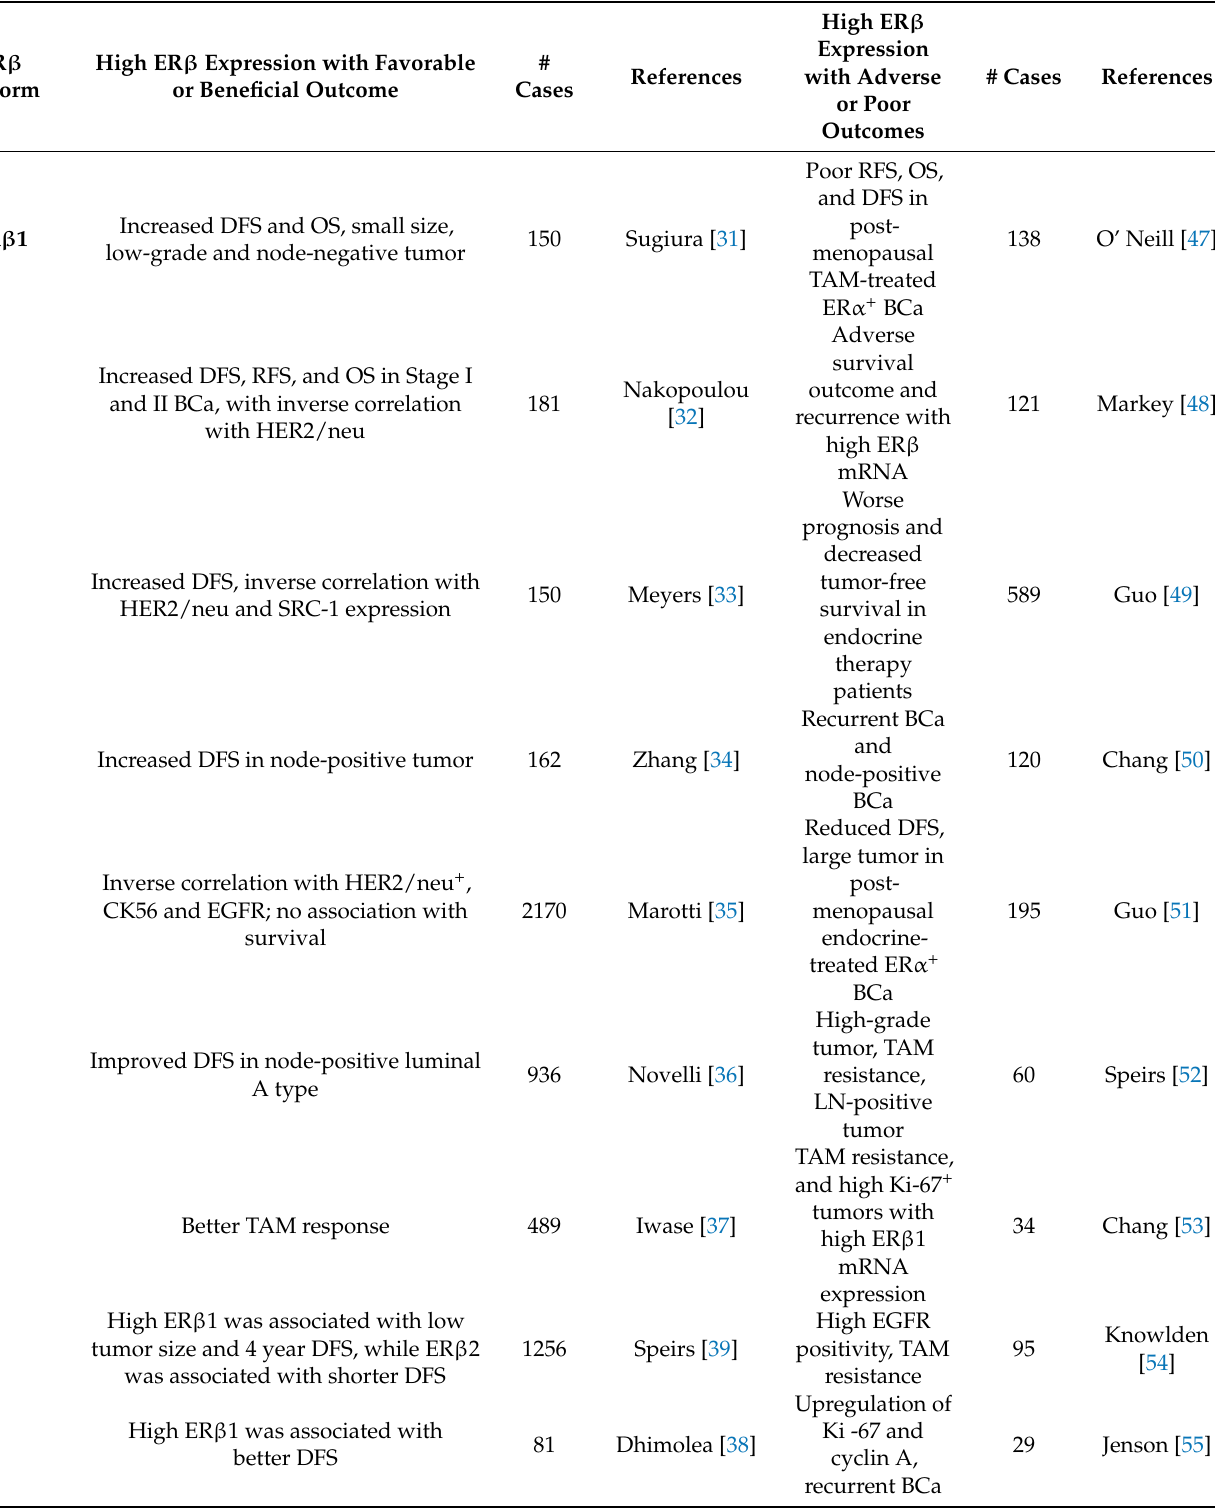
Table 7. Association of ER β isoform mRNA and protein expression with favorable and adverse clinical